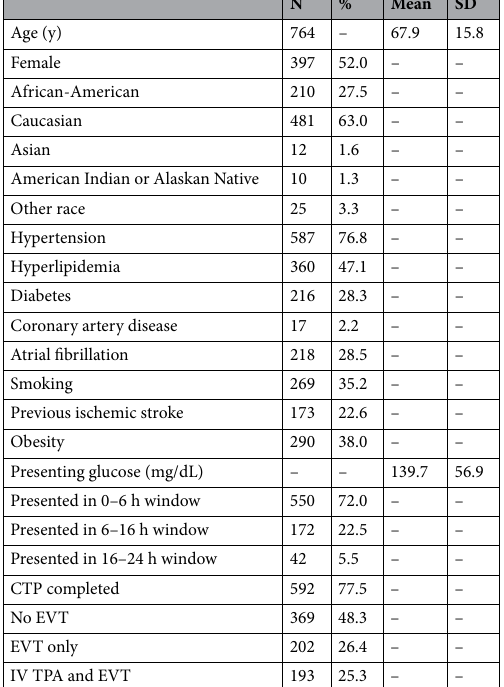
Table 2. Demographic and clinical characteristics (N = 764). SD Standard deviation, EVT Endovascular therapy, IV TPA Intravenous tissue plasminogen activator, CTP Computed tomography